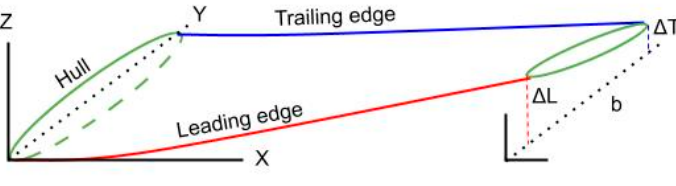
Figure 3. Definition of centerboard